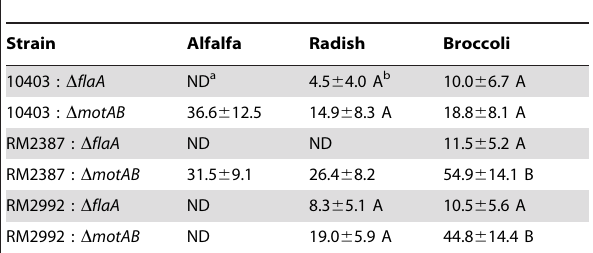
Table 3. Percent Non-motile resulting from 1:1 Competition between Wild Type and Mutant Strains on Sprouts after 3 days of